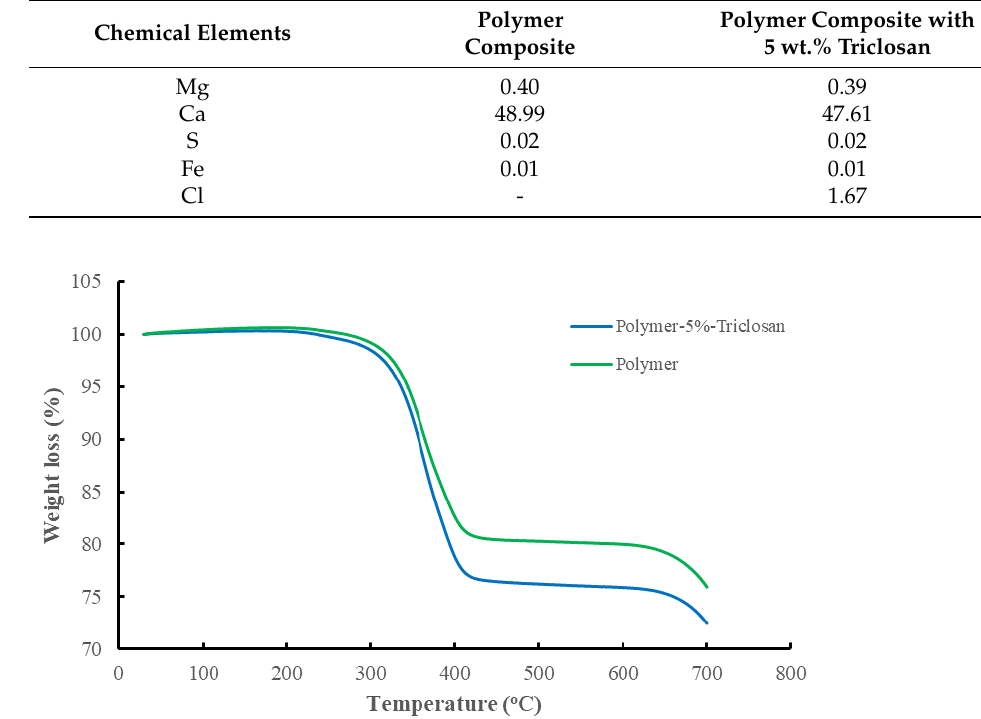
Figure 3. Thermo-analysis of the reference and 5 wt.% triclosan-loaded polymer composites.